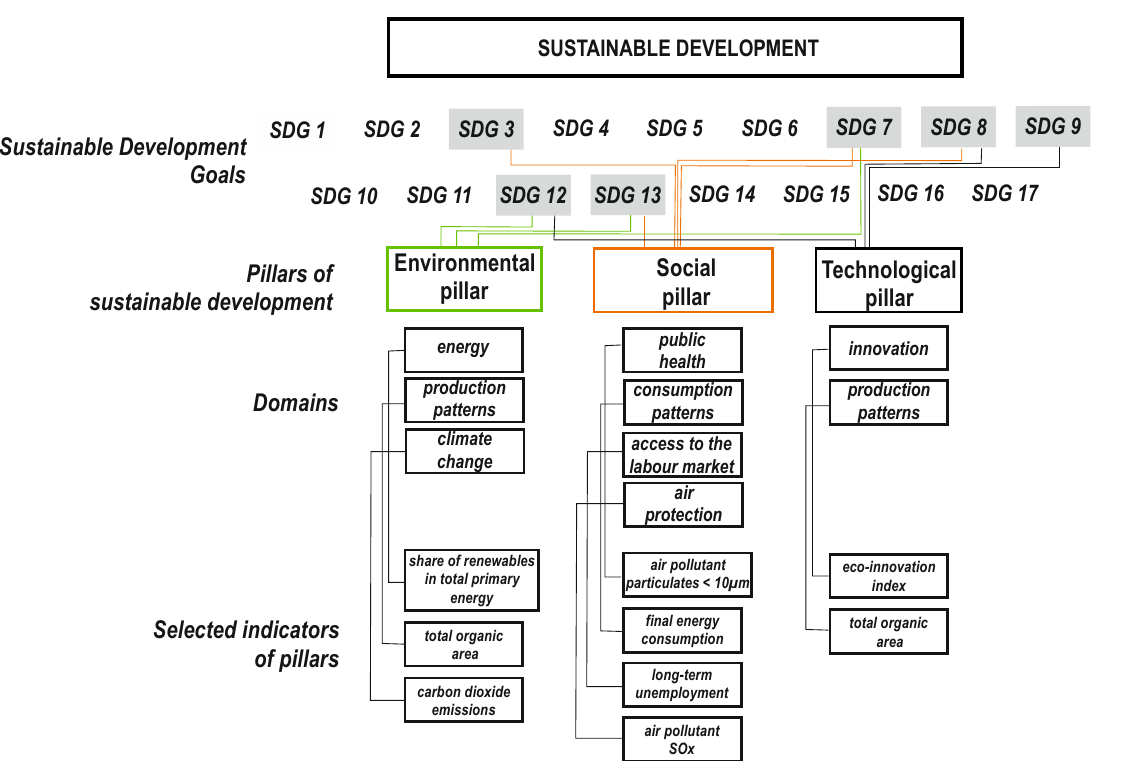
Figure 5. A flow chart showing the pursuit of sustainable development through the implementation of selected indicators in the context of diversification of energy sources. Own study, based on [10]. SDG 1: No poverty, SDG 2: Zero hunger,